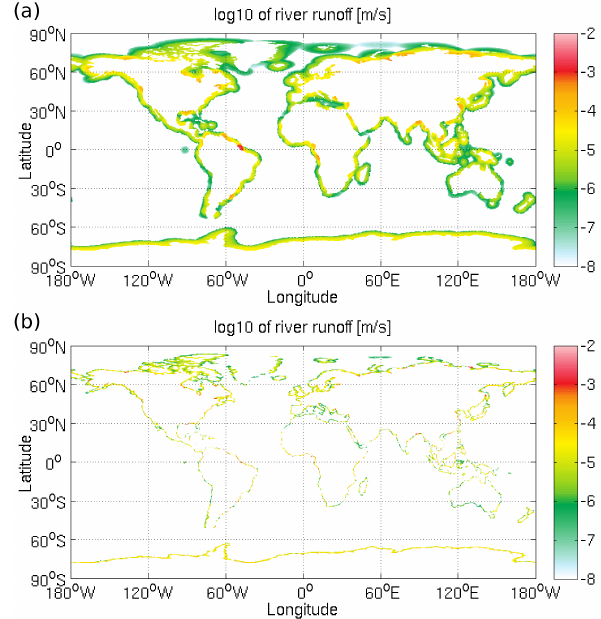
Fig. 18. Annual mean of river runoff climatology (ms − 1 ). (a) The Fig. 118. Annual mean of river runoff climatology (m/s). (a) The river runoff is distributed over 400km distance from river mouths river runoff is distributed over 400km distance from river mouths using a linear distribution function. (b) The same as (a) but over using a linear distribution function. (b) The same as (a) but over 100km.